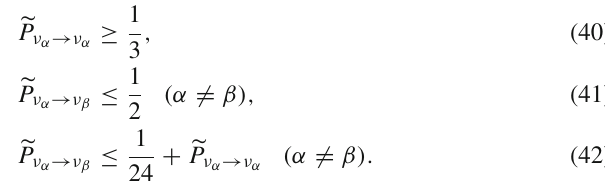
improve the limit on (cid:18)δ by one order of magnitude